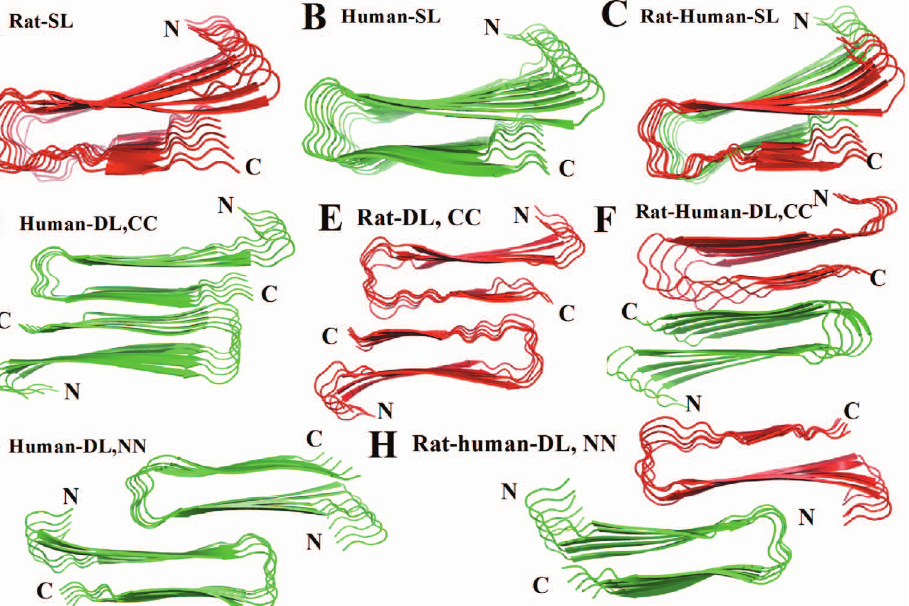
Figure 1. Structural details of the single and double layer decamers of rat amylin, human amylin and rat-human amylin mixtures. (A) Single layer conformation of human amylin, (B) single layer conformation of rat amylin, (C) single layer conformation of human-rat complex, (D) Double layer conformation of human amylin with CC interface (E) Double layer conformation of rat amylin with CC interface, (F) Double layer conformation of rat and human amylin mixtures with CC interface, (G) Double layer conformation of rat amylin with NN interface and (H) Double layer conformation of rat–human amylin complex with NN interface. Different colors are applied for the rat (red) and human amylin (green). doi:10.1371/journal.pone.0097051.g001 PLOS ONE |